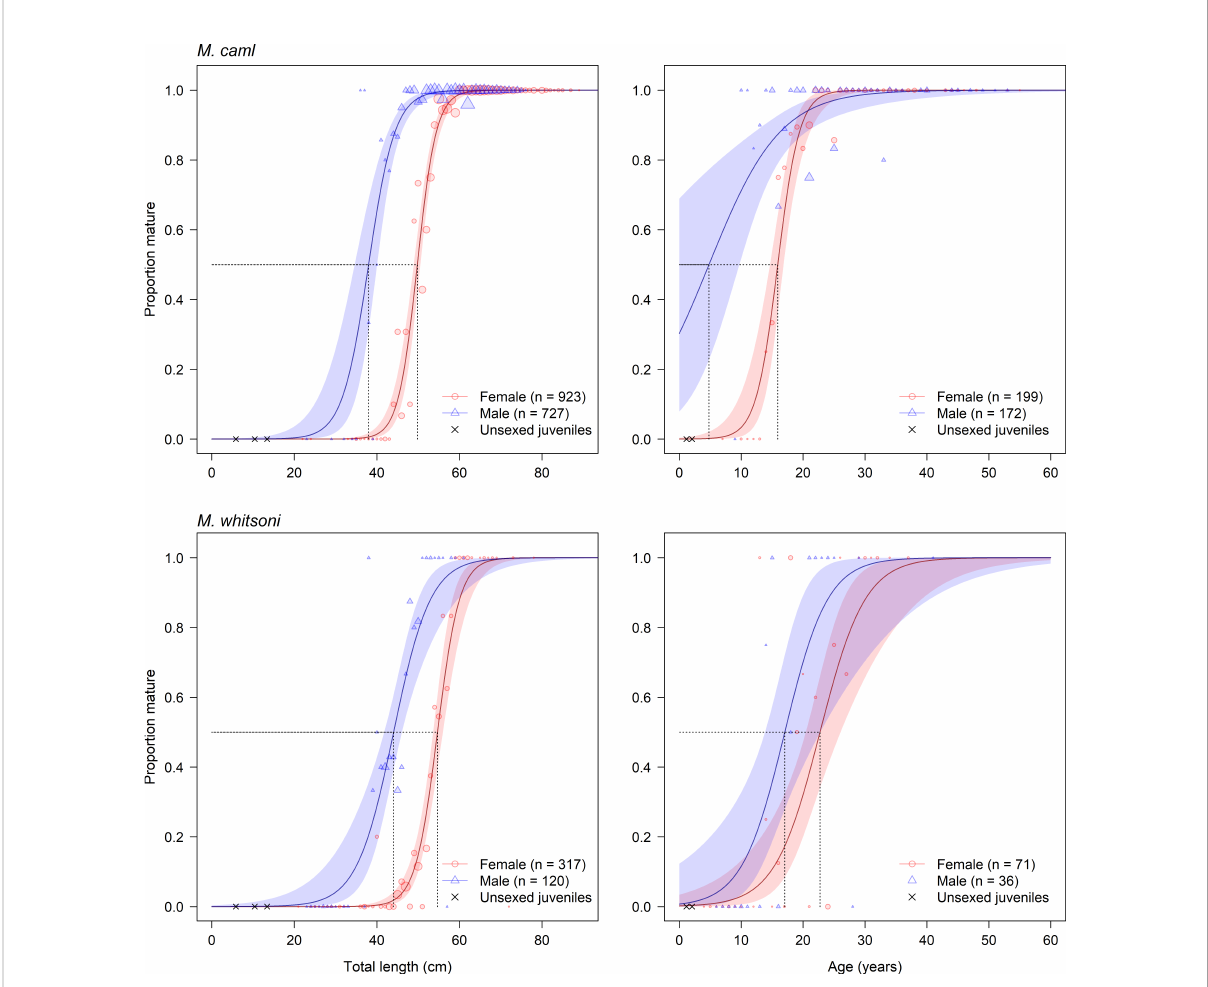
FIGURE 8 Predicted proportion of mature male and female Macrourus caml (top row) and M. whitsoni (bottom row) by length (left column) and age (right column) in the Ross Sea region. Shaded areas indicate 95% con fi dence intervals. Points represent the proportion of mature fi sh per 2 cm length class or age class, and have been scaled relative to sample sizes (largest point = 44 individuals, smallest point = one individual). Total sample sizes for each sex are indicated in